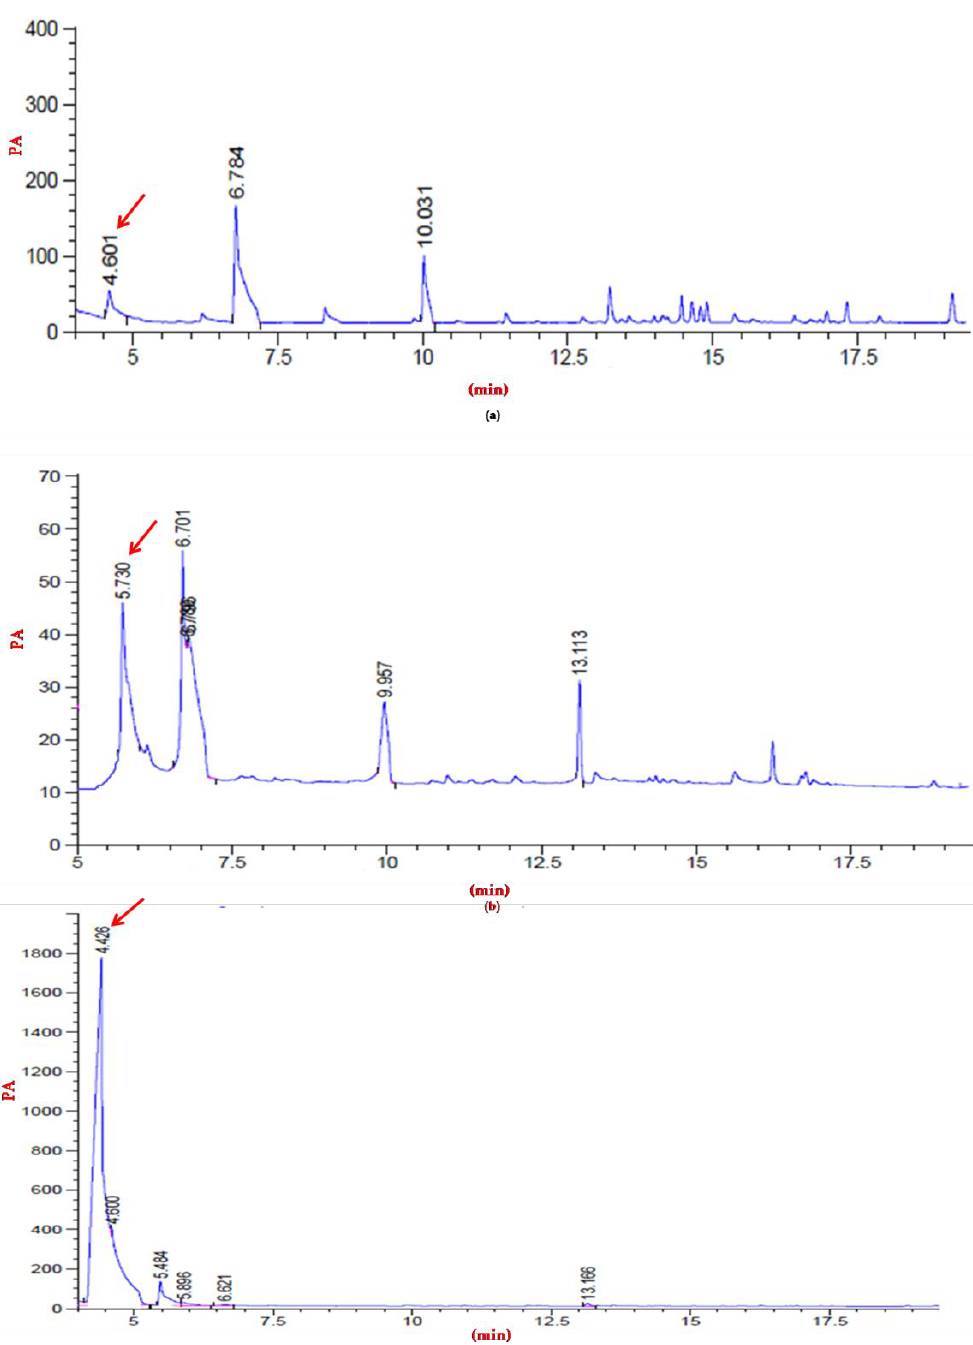
Figure 6. Gas chromatography (GC) analysis. Chromatograms of PHA obtained from cultures of the isolates ( a ) CEJGTEA101; ( b ) CEJEA36; and ( c ) PHB standard (Sigma). The peaks at 4.6 min and at 5.7 min represent the 3-hydroxybutyrate methylester and the 3-hydroxyvalerate methylester, respectively.